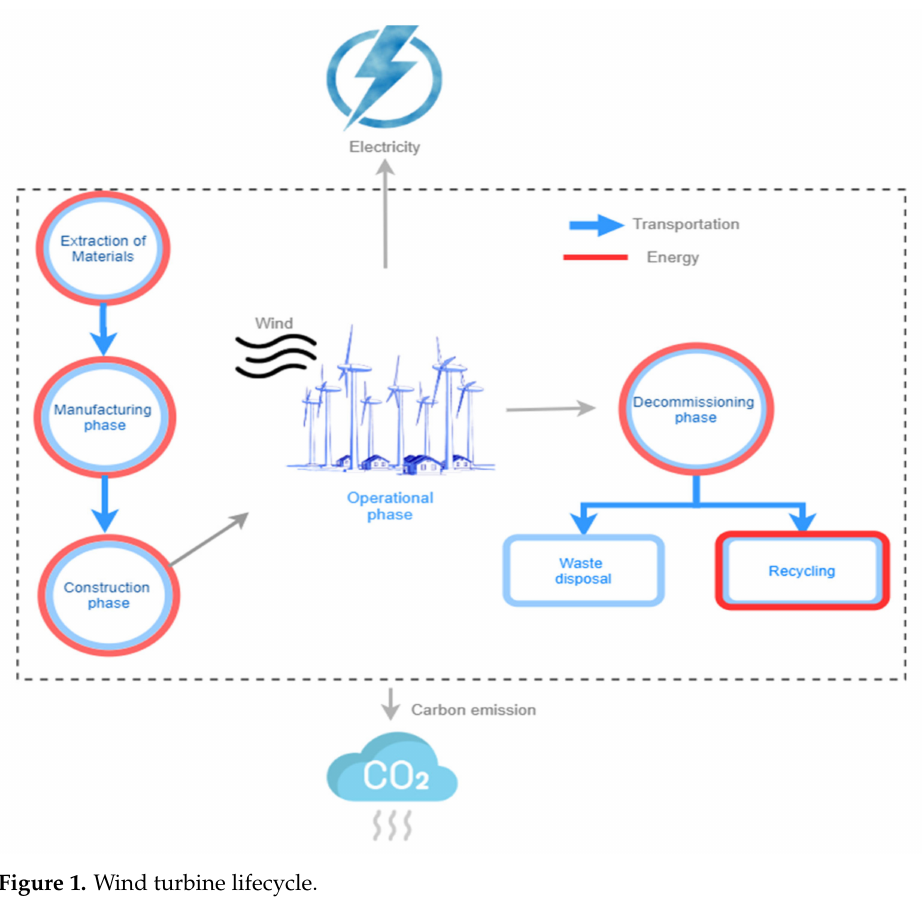
Figure 1. Wind turbine lifecycle.